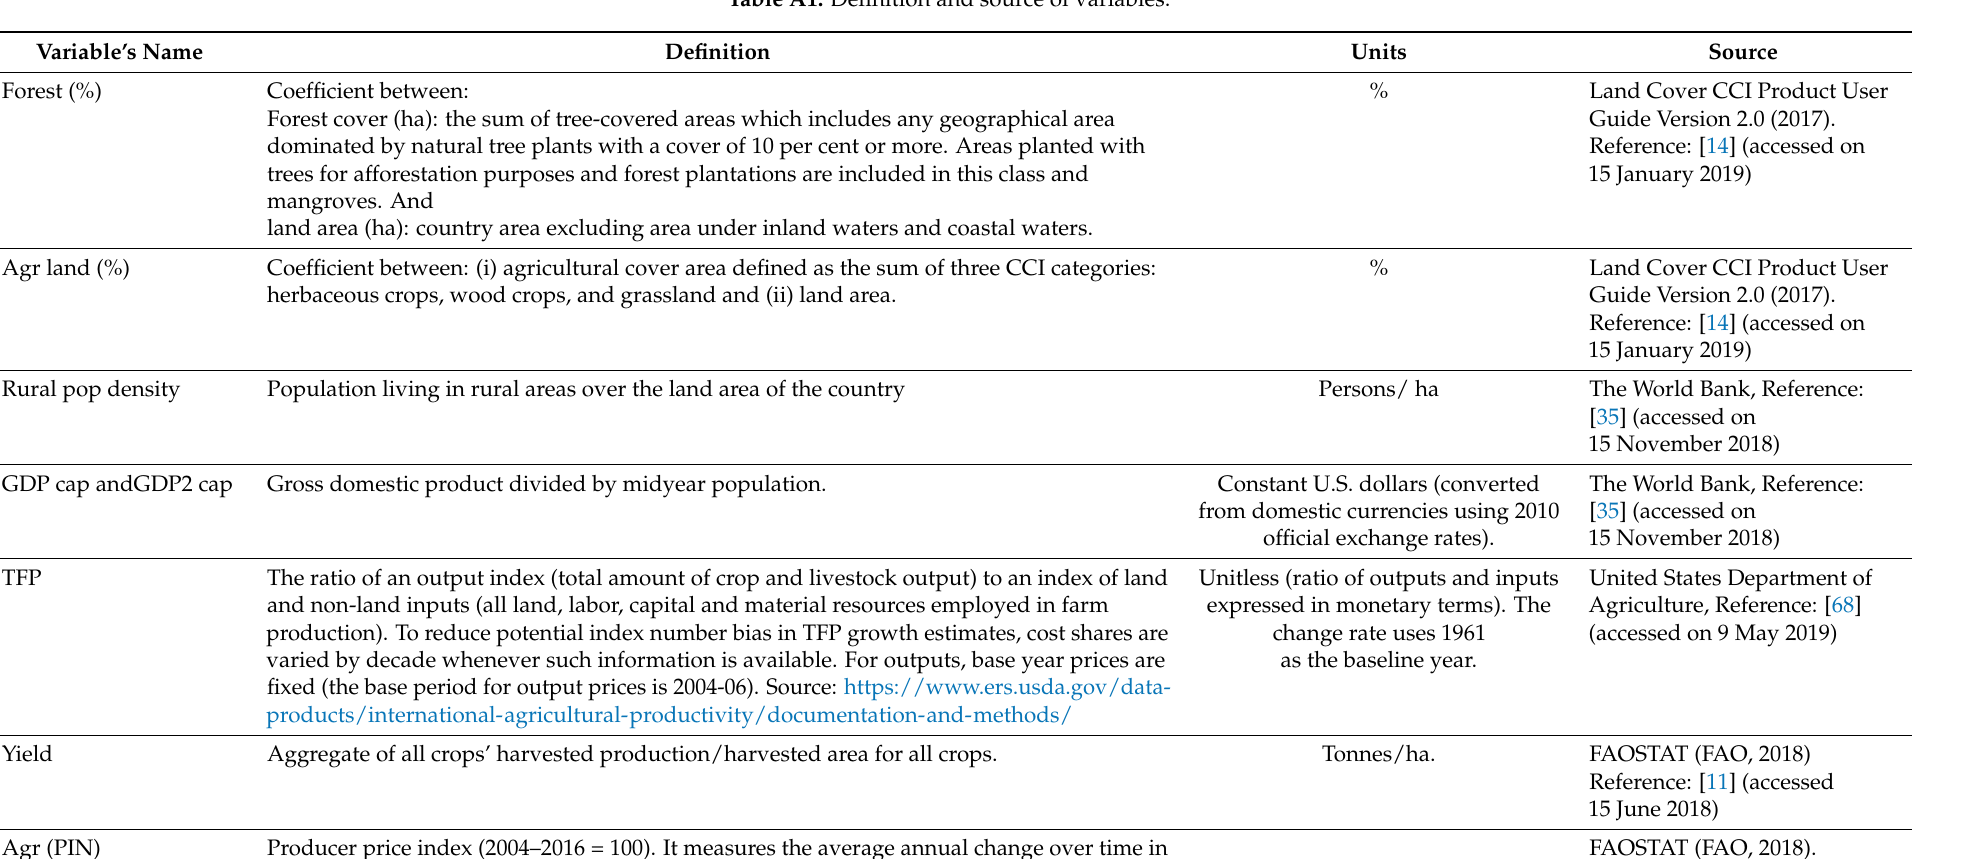
Table A1. Definition and source of